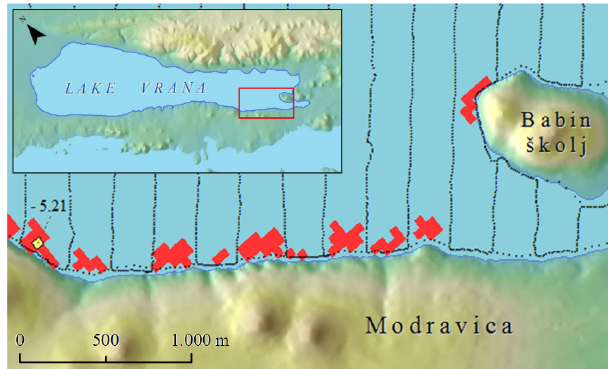
Figure 6. Areas that were not directly measured during the survey (red